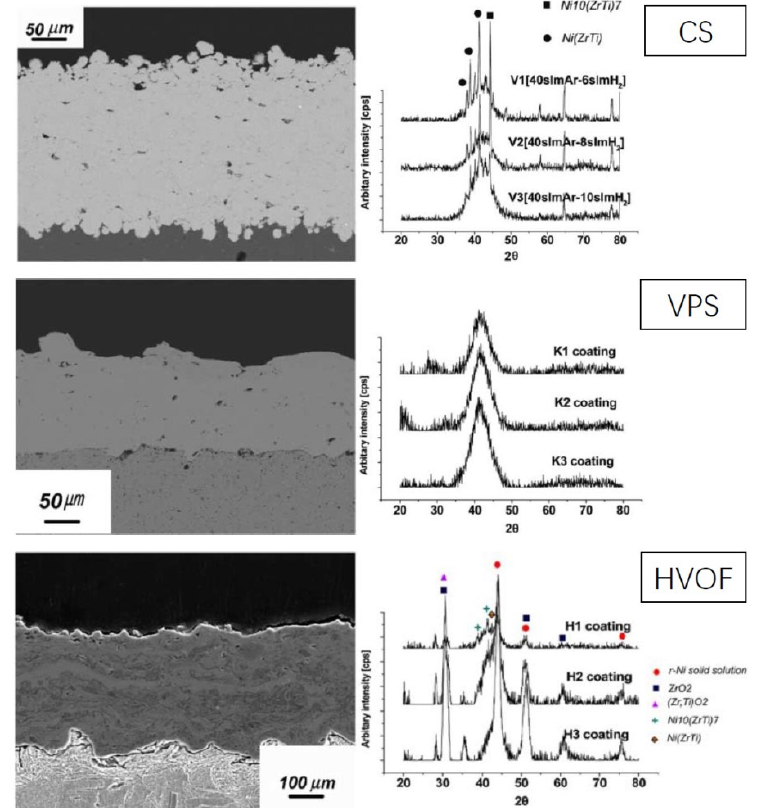
Figure 7. Cross-sectional backscatter electron micrographs (left) and XRD phase analysis results of Ni-based amorphous coatings prepared by cold spray and thermal spray techniques. Reprinted with permission from [41] Copyright 2021 Elsevier .